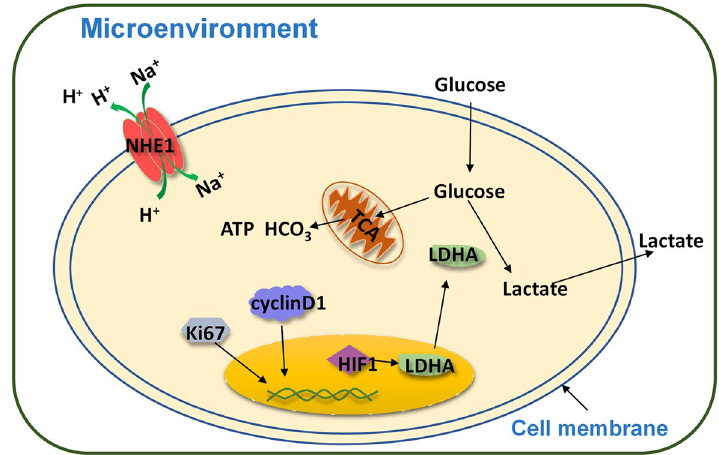
Figure 6. Schematic diagram of proteins promoting tumor